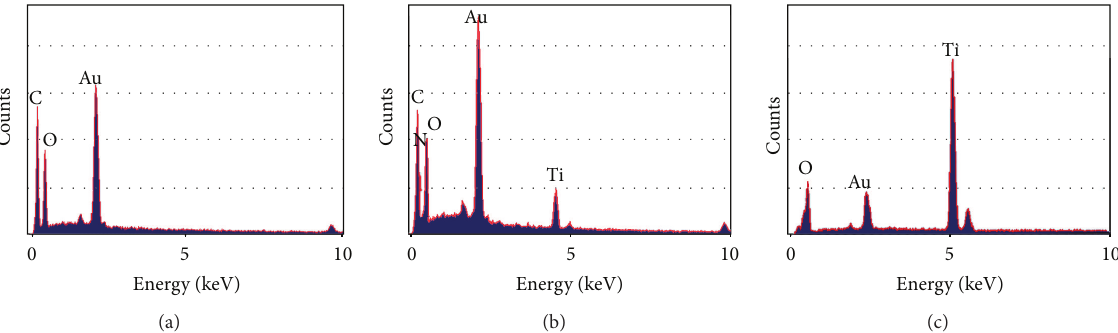
Figure 3: EDS spectra of (a) the original wood, (b) wood coated by TiO 2 sol, and (c) wood-templated TiO 2 .